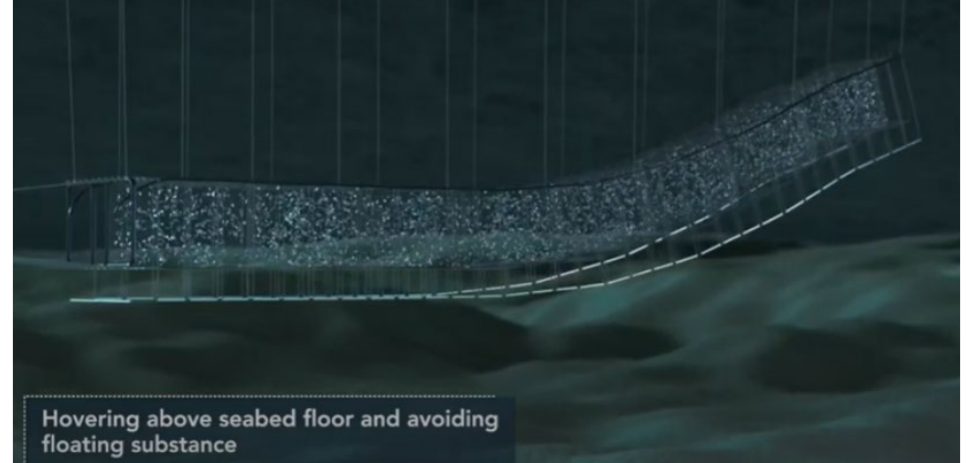
Figure 13. Linear tensile system Gili subflex – submerged— (https://www.giliocean.com/selected-pro- jects (accessed on 22 September 2022)).